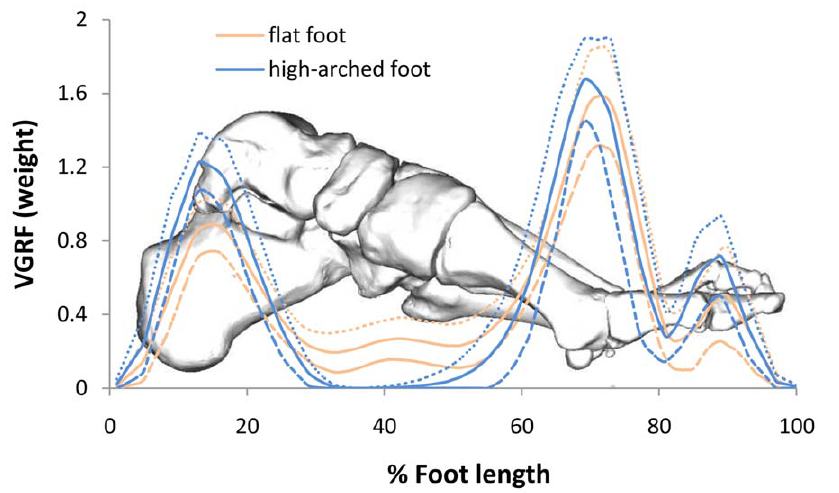
Figure 2. Distributions of VGRF of foot in stance phase. The blue (deep) solid line refers to the plantar VGRF of the high-arched foot while the blue (deep) ribbon presents the error bars of the plantar VGRF of the high-arched. The red (light) solid line stands for the plantar VGRF of the flat foot while the red (light) ribbon for the standard error bars of the plantar VGRF of the flat foot. The VGRF has been standardized as 1 by weight, and the stride cycle time and foot length are rated by percentage.